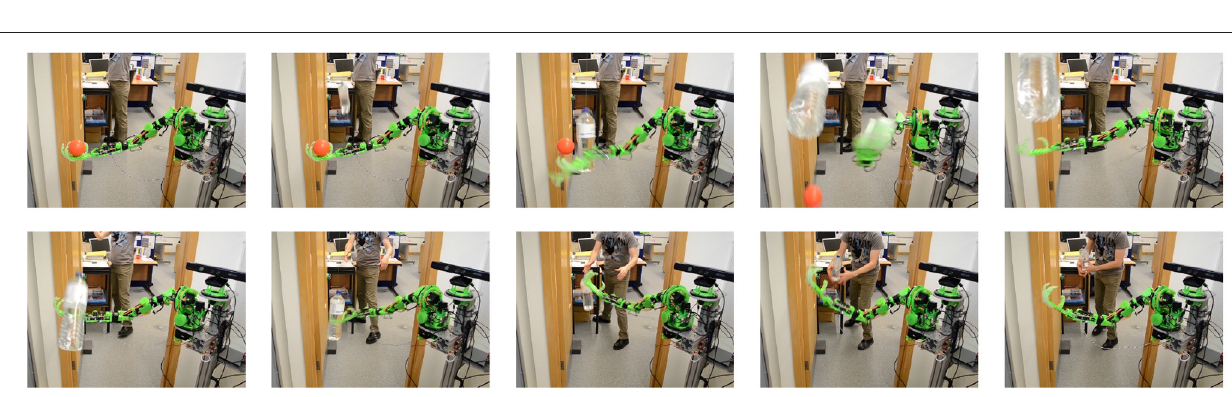
FIGURE 12 | A 3D-printed robot does not necessarily mean a fragile robot. A 2 kg mass (an unopened 2 liter water bottle) attached to a string in tension was released from a height of 1.3 m above the robot arm. The mass swung down and hit the robot at the wrist when close to its point of maximum velocity. The bottle hit the arm a second time when swinging back. No damage was done to the robot, which remained fully functional after the impacts. Images taken at 0.25 second intervals, representing 2.25 seconds. See full video here: https://youtu.be/945XSTuKtAI. shown that the elasticity of a joint can be exploited to achieve tasks, while adapting online to changes in arm co-contraction, point to point goal-directed periodic movement, by tuning load and human intervention. Thus, the system coupled the the elasticity to shape the natural modes of the system. The simple CPGs with the world, through the soft joints of the GummiArm joints could serve well for future experiments in GummiArm, which drove the error signal used by the learning this algorithm. Interestingly, Bonacchi et al. (2021) have recently